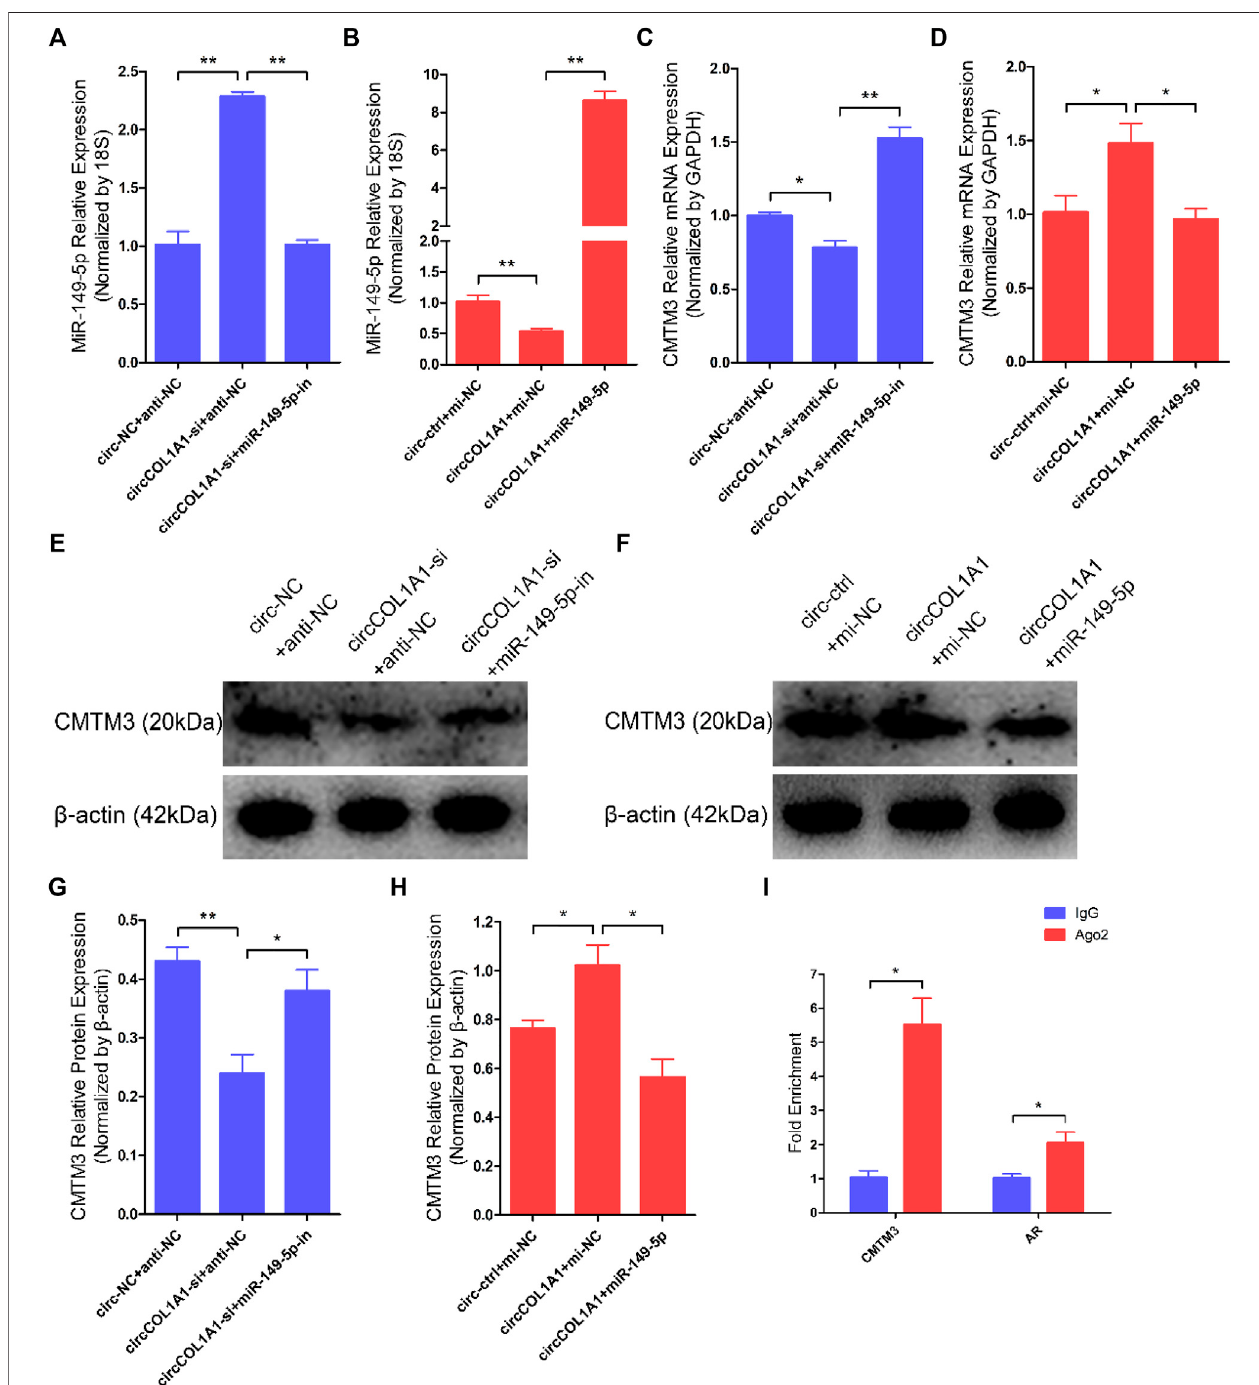
FIGURE 9 | CircCOL1A1 regulates miR-149-5p and CMTM3 expression in goat hair follicle stem cells. (A,B) Expression of miR-149-5p in hair follicle stem cells after cotransfection with circCOL1A1-si and miR-149-5p-in (A) and with circCOL1A1 and miR-149-5p (B) . (C,D) The relative expression of CMTM3 in hair follicle stem cellsaftercotransfectionwithcircCOL1A1-siandmiR-149-5p-in(C)andwithcircCOL1A1andmiR-149-5p(D). (E,G) CMTM3proteinexpressioninhairfolliclestemcells after cotransfection with circCOL1A1-si and miR-149-5p-in. (F,H) CMTM3 protein expression in hair follicle stem cells after cotransfection with circCOL1A1 and miR-149-5p. (I) Fold enrichment of CMTM3 and AR determined by RT-q-PCR following the RIP assay with Ago-2 antibody and IgG antibody (negative control).